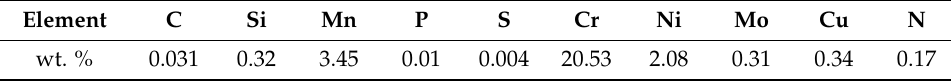
Table 1. Chemical composition of DSS